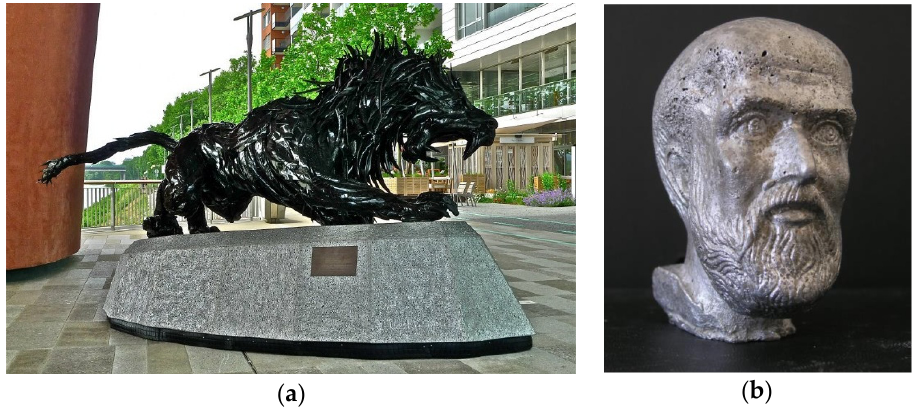
Figure 22. ( a ) Statue support made of Alusion foam (courtesy of Alusion); and ( b ) head of Pythagoras made of Alulight metal foam by the Slovak Academy of Sciences (courtesy of Fero Siman č ík, SAS).